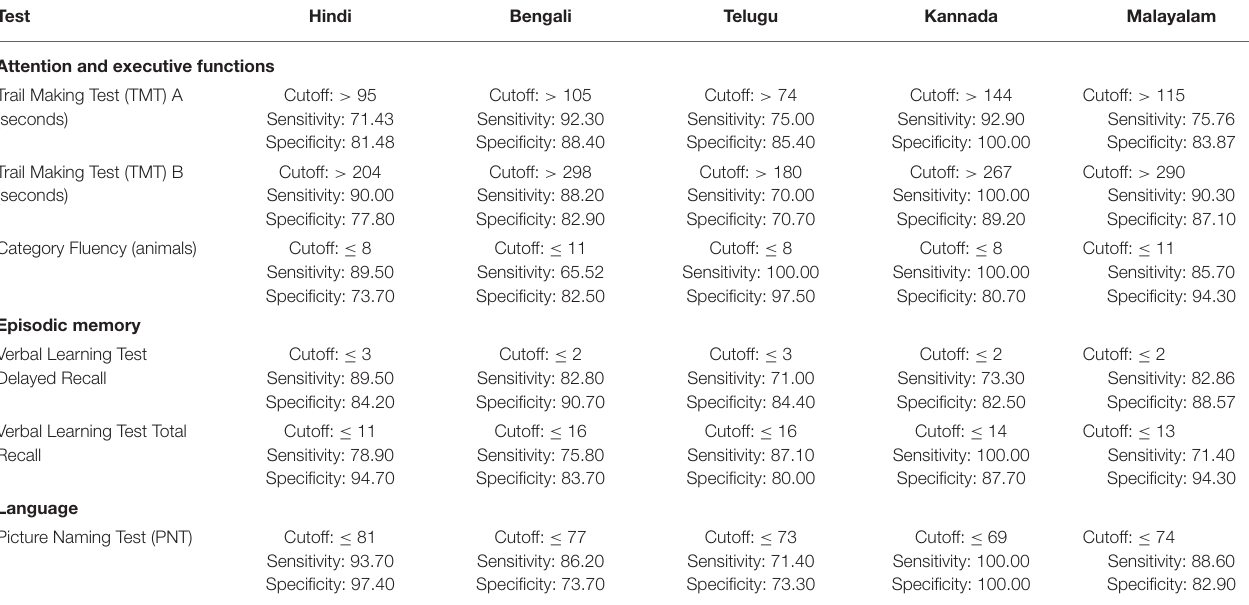
TABLE 4 | Optimal cutoff scores and the respective sensitivity and specificity of ICMR-NCTB tests for diagnosis of dementia across five languages.